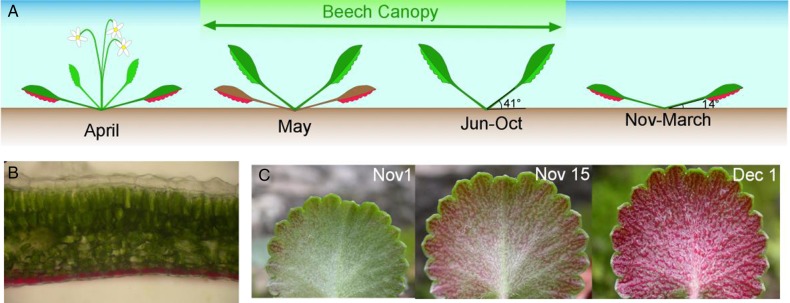
Characterization of anthocyanic leaves of S. hirsuta. In (A), the growth, seasonal change in leaf angle and reddening processes are represented. In (B), an optical microscopic image of anthocyanic leaves shows the abaxial anthocyanic epidermis responsible for the red colour. In (C) the reddening process of S. hirsuta leaves is depicted.